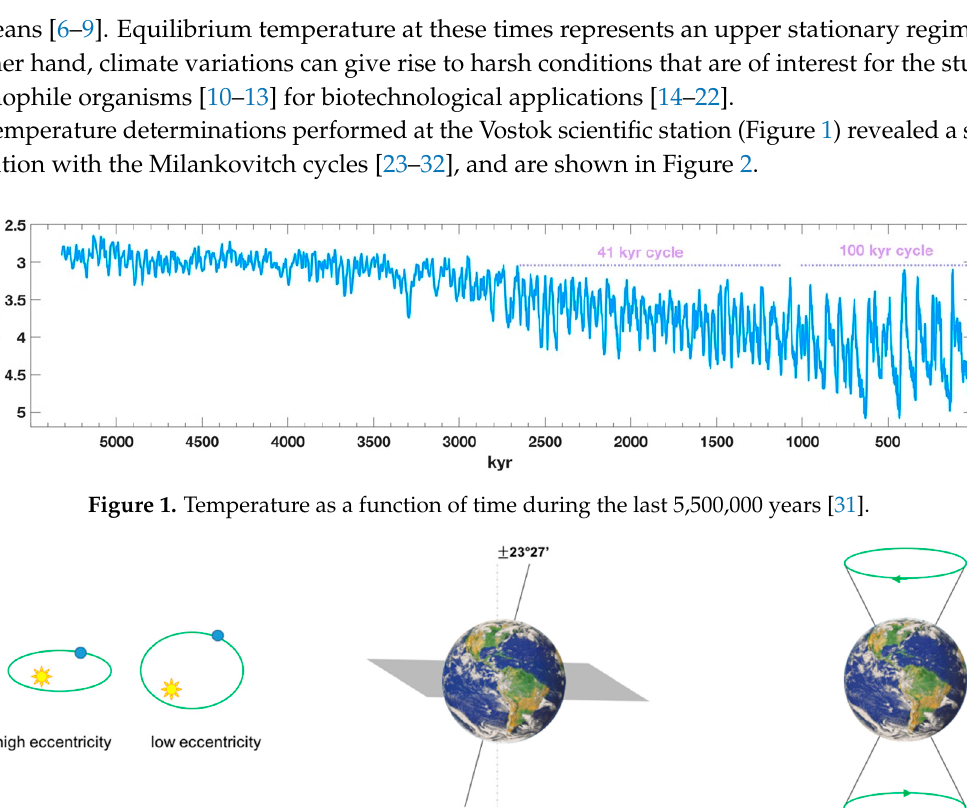
Figure 2. Three Milankovitch cycles.